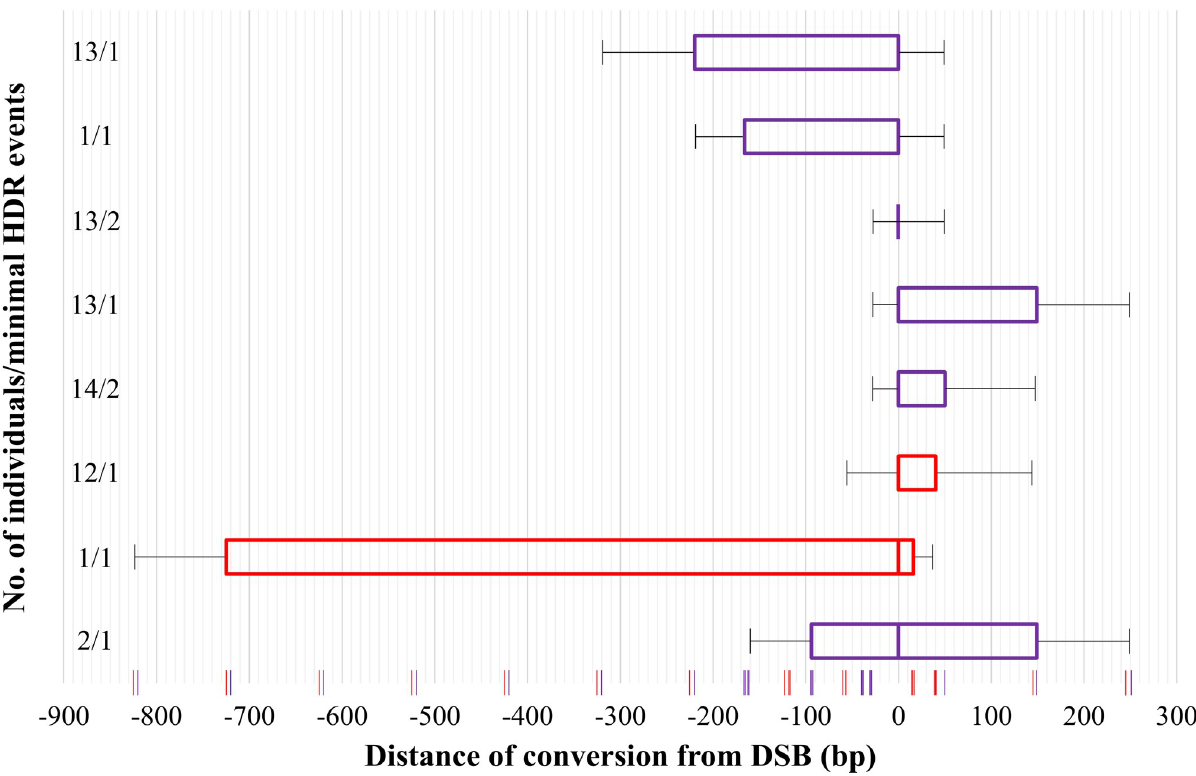
Fig 3. Characteristics of gene conversion tracts in perfect repair events generated with constructs 190-recoded (red bar) and 234-recoded (purple bar). Positions of SNPs within the homology arms, relative to the cut sites for 190-recoded and 234-recoded , are marked with red and purple vertical lines, respectively (See Tables C and D in S1 File for specific nucleotide changes introduced). Count of HDR events indicates the number of individuals, and independent pools from which a conversion of that size range was recovered. Error bars indicate the range of possible conversion tract lengths which could not be detected by